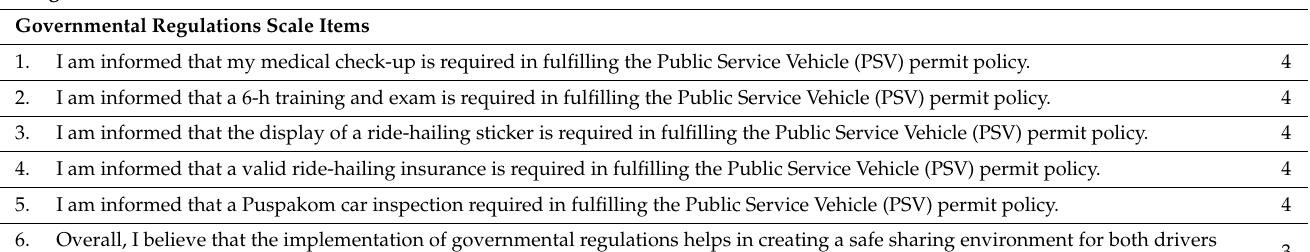
Table A3. Rating Matrix for Governmental Regulations.